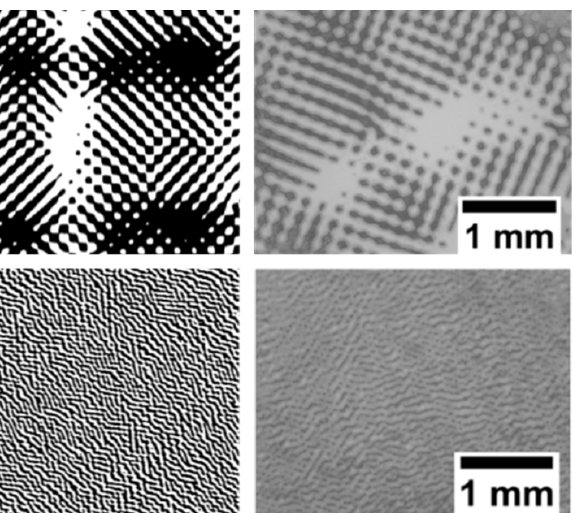
Figure 5. Comparison between the theoretical ( left ) and experimental ( right ) amplitude profiles recorded in the multilayer stack. Top, crosshair target visor and bottom, guitars.